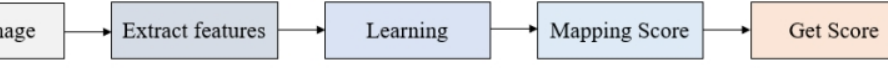
Figure 6. The general framework of learning ‐ based methods.